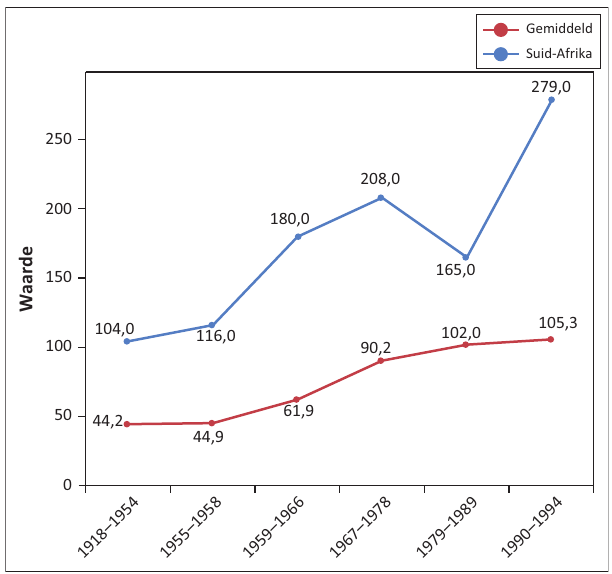
FIGUUR 1: Suid-Afrika se veranderende graadsentraliteit in vergelyking met die gemiddelde graad in die wêreldhandelnetwerk. dui dat Suid-Afrika altyd ’n bogemiddelde rol in die wêreldhandelnetwerk gespeel het. Figuur 2 verskaf ’n meer gedetailleerde uiteensetting van Suid-Afrika se veranderende graadsentraliteit, in- en uitgraad, tussenliggingsentraliteit en nabyheidsentraliteit. Dié figure is ook ter wille van vergelykingsdoeleindes vir die VSA en VK verskaf.